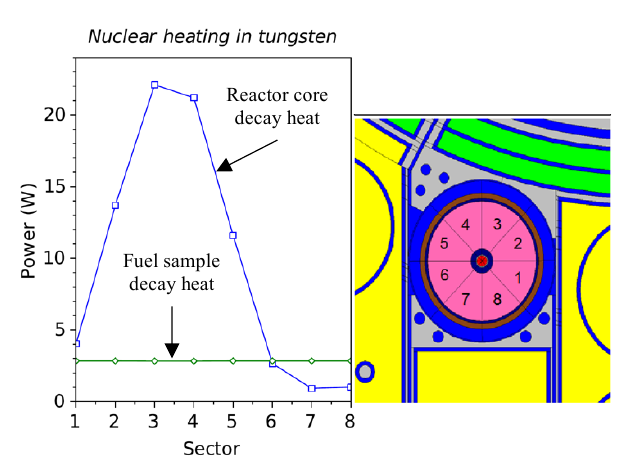
Fig. 6. Nuclear heating in the tungsten shield of the device configuration number 1. Fuel sample and reactor core